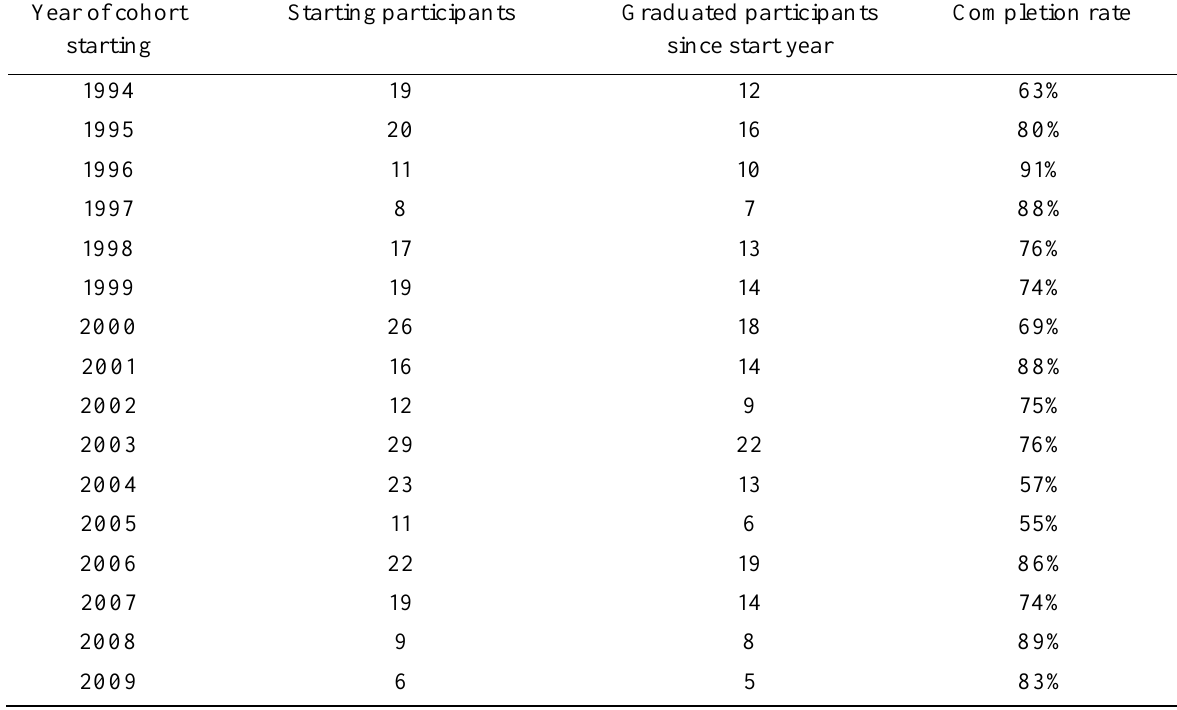
Table 1 Doctoral Student Graduation Rates Year of cohort